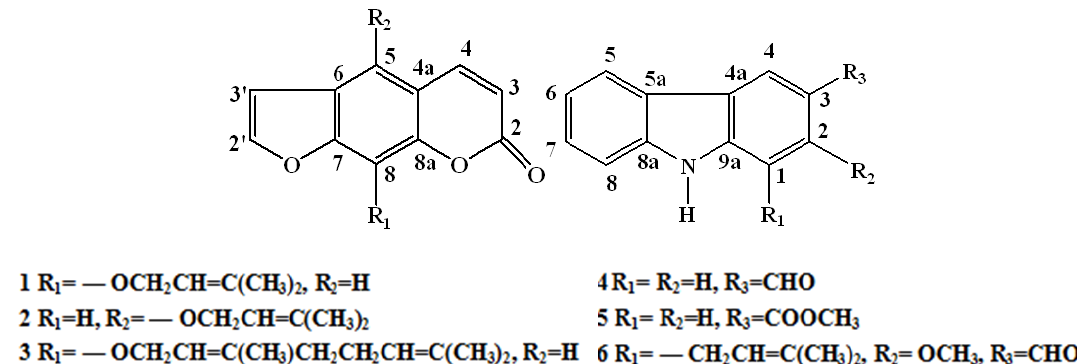
Figure 1. The structures of compounds 1 – 6